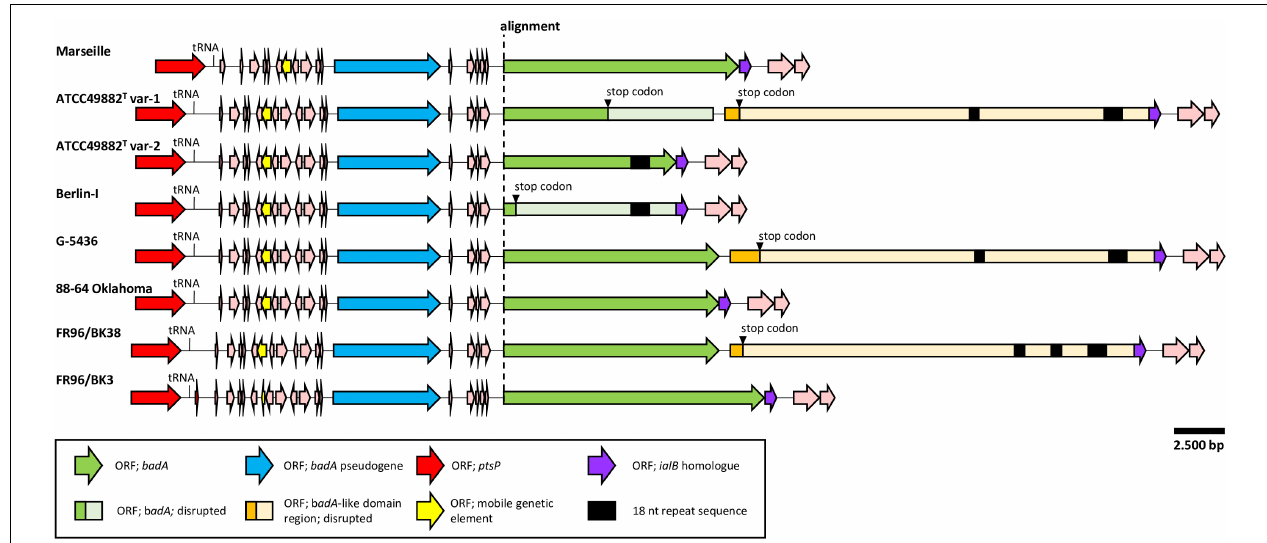
FIGURE 2 | Comparative genetic organisation of the chromosomal badA island region. All regions are shown in the same orientation. The conserved upstream ORF (blue) is a badA pseudogene containing the typical TAA C-terminal anchor domain. A higher sequence variability is found within the badA gene (green), where a premature stop codon is observed in strains ATCC49882 T var-1 and Berlin-I. Strains ATCC49882 T var-1, G-5436, and FR96/BK38 share an exceptionally long ORF (orange), named the badA -like domain region that is located downstream of badA . These three ORFs also contain the typical TAA C-terminal anchor domain. Additional small ORFs are found between the upstream badA pseudogene and badA as well as other ORFs flanking the badA island (pink). In five displayed badA island sequences, two or three unique repeat regions (black rectangle) in either badA or in the downstream BadA-like domain region are